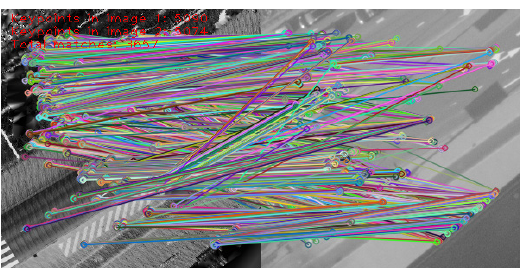
Figure 11. Hamming distance based descriptor matching of an example tile with five nearest neighbours